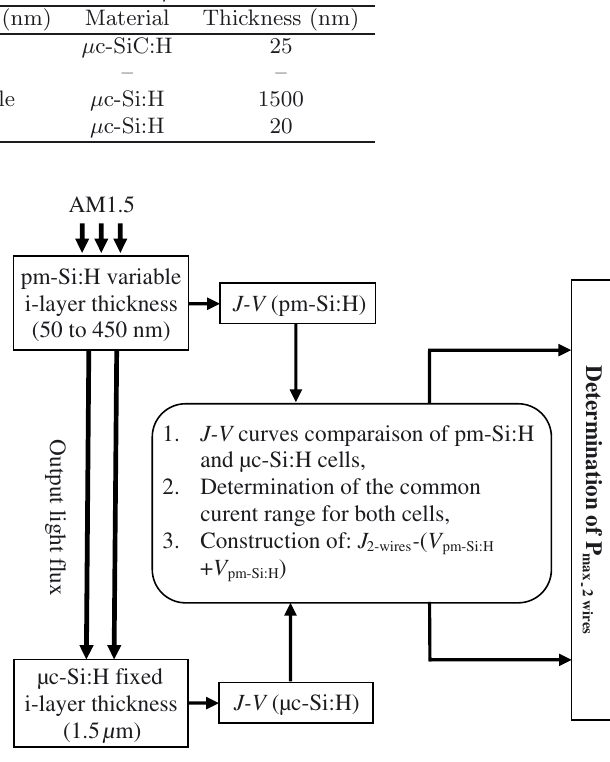
Fig. 3. Simulation steps for a two-wire tandem structure.